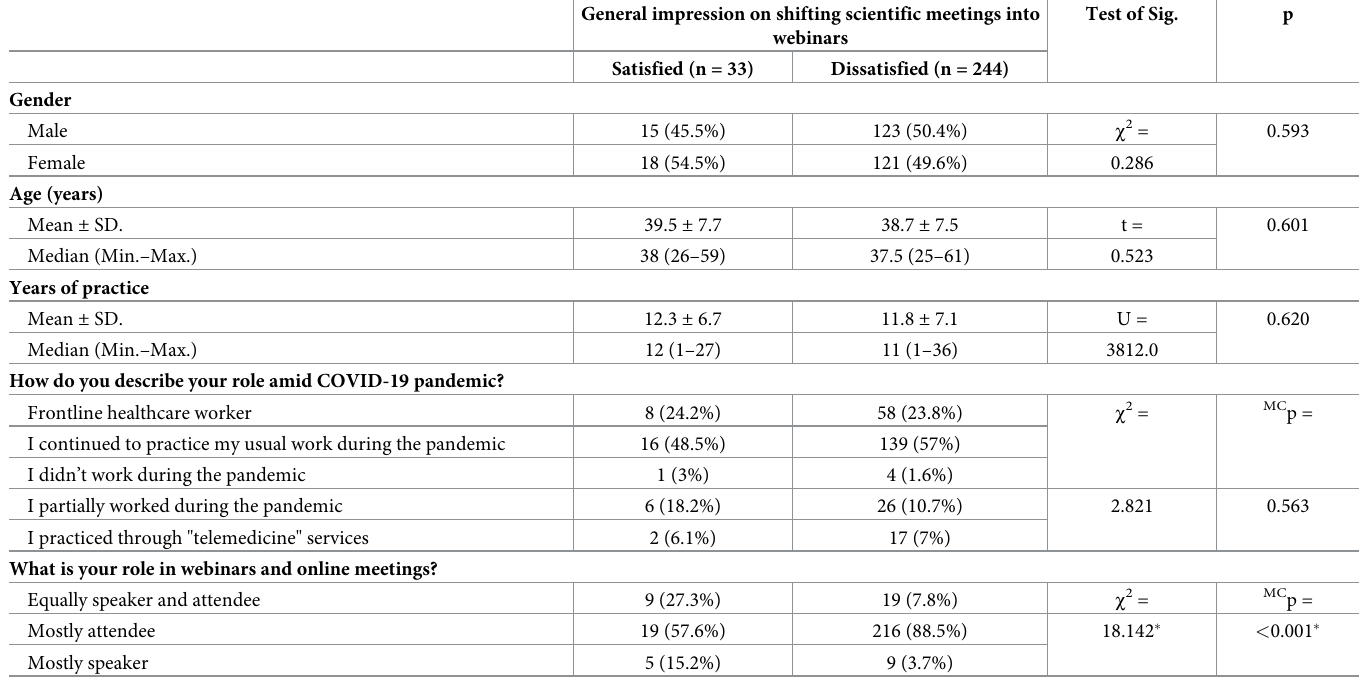
Table 5. Comparison between satisfied and non-satisfied groups on shifting scientific meetings into webinars with different parameters (n =